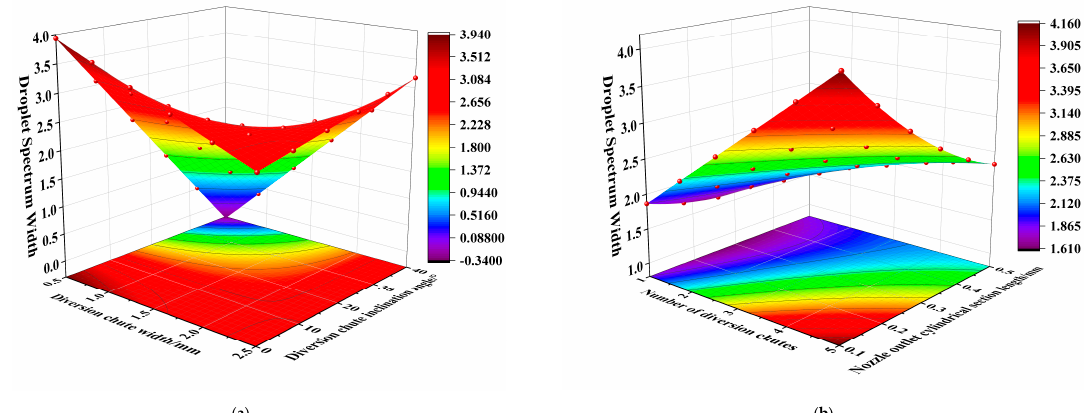
Figure 12. Two-factor interaction effect diagram of the droplet spectrum width. ( a ) Interaction effect between b and β , ( b ) interaction effect between n and h 2 .